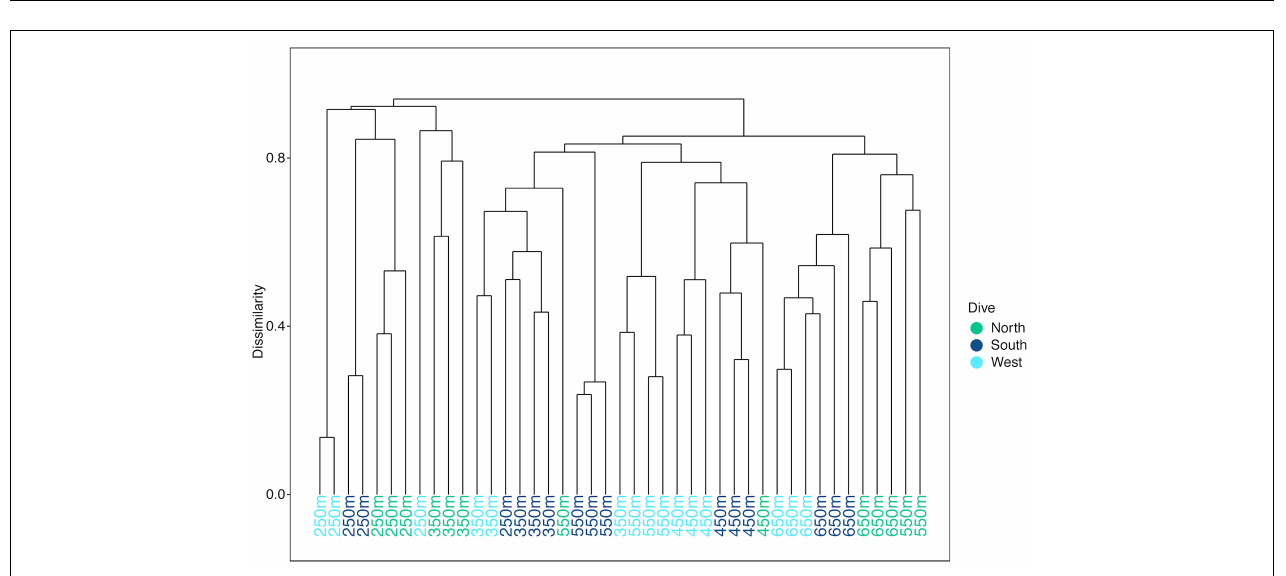
FIGURE 9 | Hierarchical cluster diagram for three slopes of Mokumanamana for transects labeled by depth bin and color coded by side.